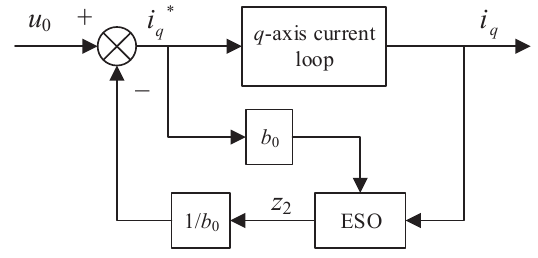
Figure 1. ESO-based q -axis current